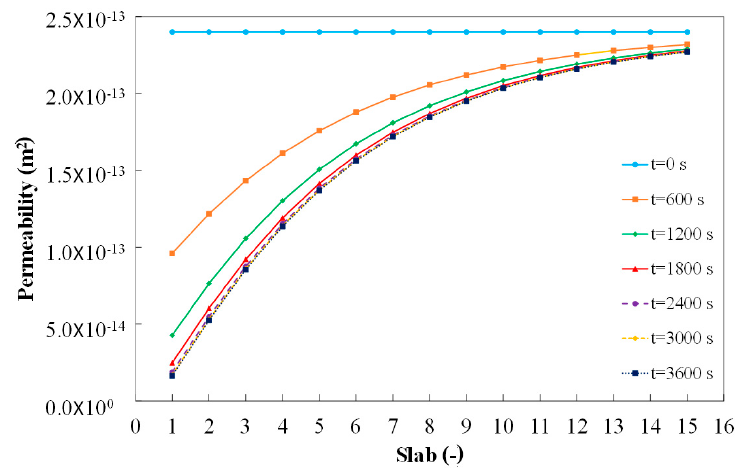
Figure 10. Evolution with the time of permeability in each slab of the porous medium.